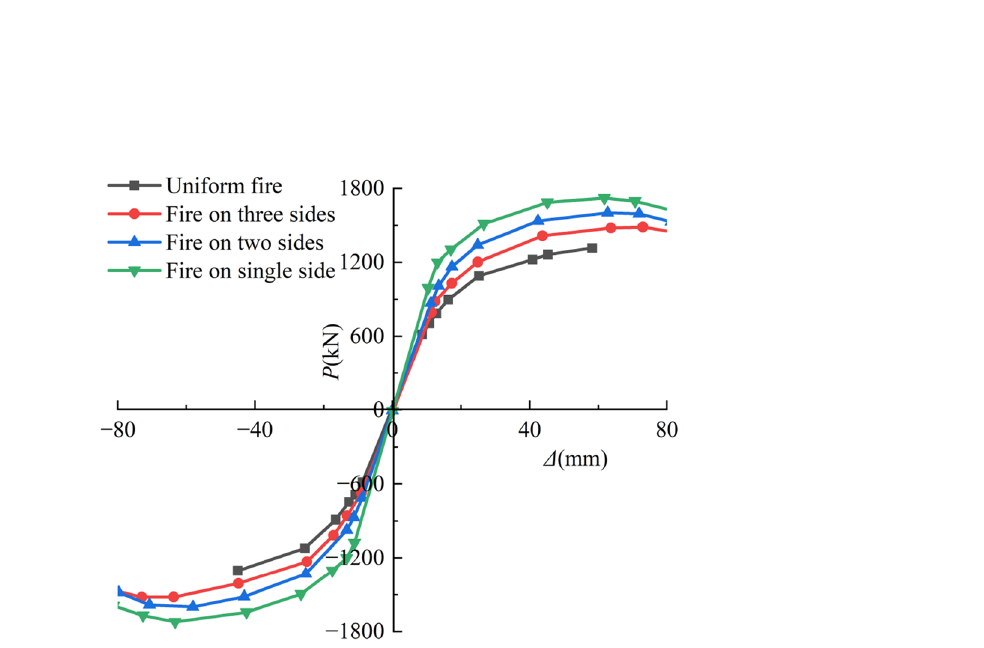
Figure 16. Skeleton curves of P-Δ